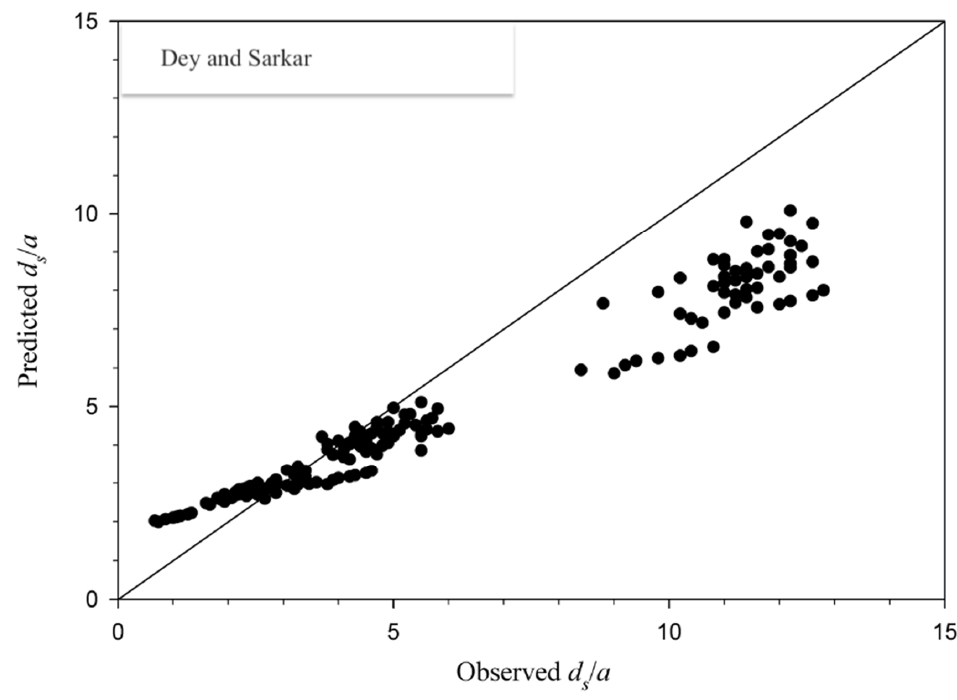
Figure 9. Comparison of experimental d s / a with that computed using Dey and Sarkar [15] equation. Equation (4) can be used to predict maximum scour depth for both smooth and rough aprons under wall jets. Figure 10 shows the comparison of experimental d s / a with that computed using Equation (4). The coefficient of regression between the computed and observed maximum scour depths is 0.92. This indicates that the computed maximum scour depth is in conformity with the observed maximum scour depth. Other statistical parameters were found to be as follows: RMSE = 0.09, MAPE = 0.32, and Scatter Index = 0.24. The experimental data of Chatterjee et al. [7] and Dey and Sarkar [15] were also used to calculate the maximum depth of scour using Equation (4) and plotted in the same figure for comparison. The equation fairly predicts the maximum depth of scour for the experi- mental data of Dey and Sarkar [15], while over-predictions are observed for the data of Chatterjee et al. [7].